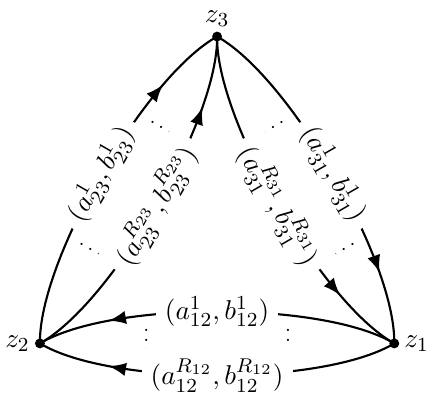
(cid:12) (cid:12) h i A 12 A 23 A 31 (cid:12) (cid:12) . (cid:12) (cid:12) B 12 B 23 B 31